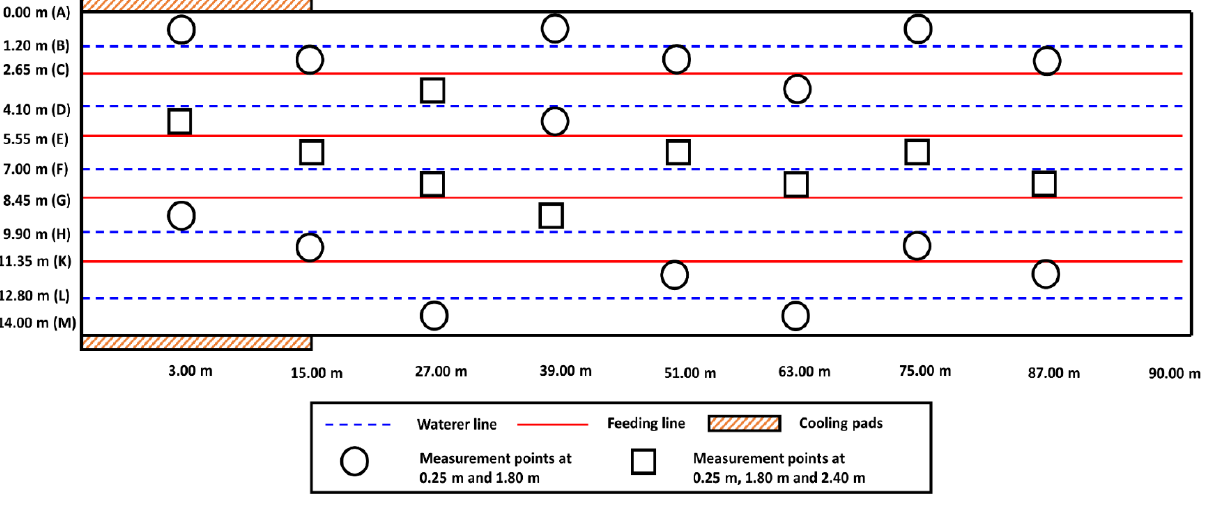
Figure 2. Measurement locations for airspeed, temperature, and relative humidity measurements inside the house.